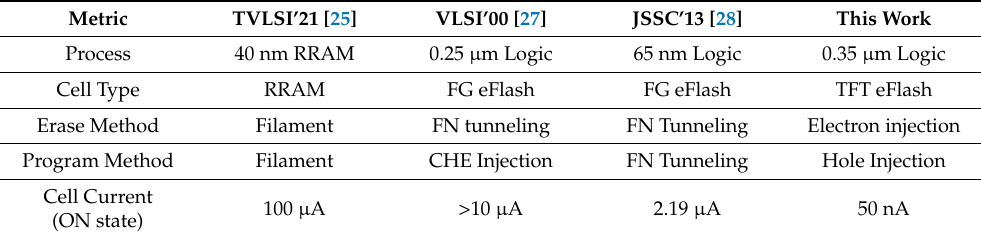
Table 6. Comparison of the memory